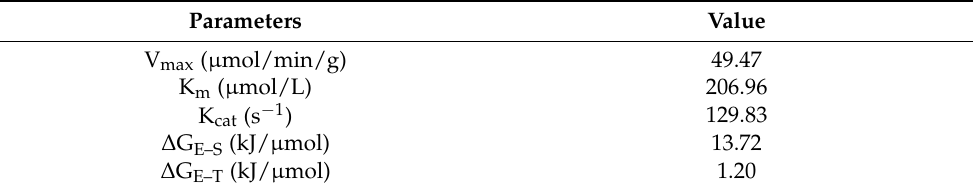
Table 4. Kinetic and thermodynamic parameters for the immobilized lipase (freeze-dried fermPSR).